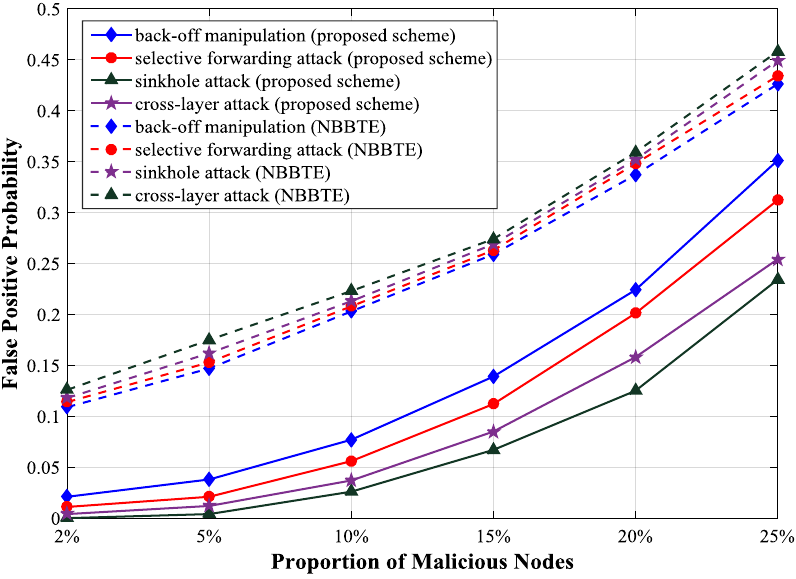
Figure 10. Comparison of the false positive probability .